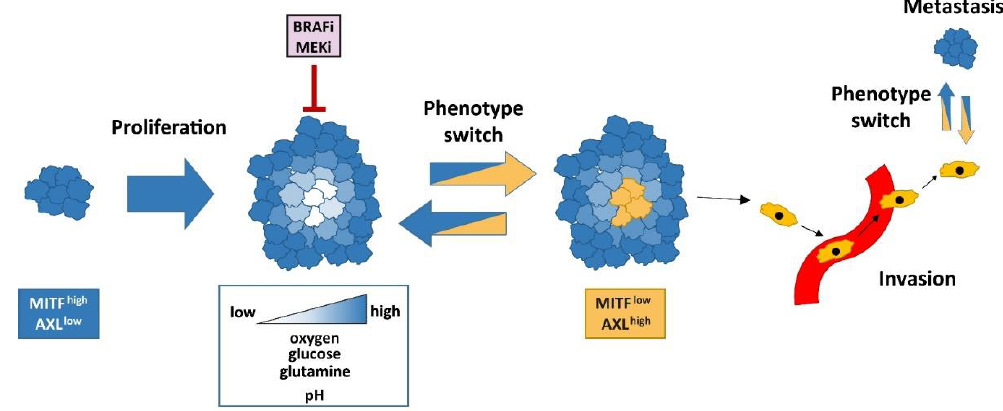
Figure 2. Phenotype switch in melanoma. Cells expressing high levels of MITF and low levels of the receptor tyrosine kinase AXL are characterized by high proliferative capacity and thereby promote tumor growth. As a result, melanoma cells located at the center of the growing tumor often experience a decrease in oxygen, glucose, and glutamine levels, which also contributes to acidic extracellular pH levels. These changes of the tumor microenvironment can trigger a switch from a MITF high AXL low to a MITF low and AXL high phenotype. Cells of this phenotype barely proliferate but they have an increased invasive capacity and promote the formation of metastases. Similarly, systemic therapies inhibiting BRAF and MEK (BRAFi, MEKi) can also promote phenotype switching towards a MITF low AXL high phenotype.